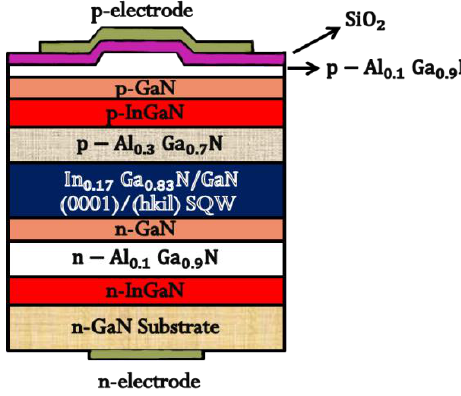
Figure 3. Structure of In 0.17 Ga 0.83 N / GaN single QW (SQW) blue laser.